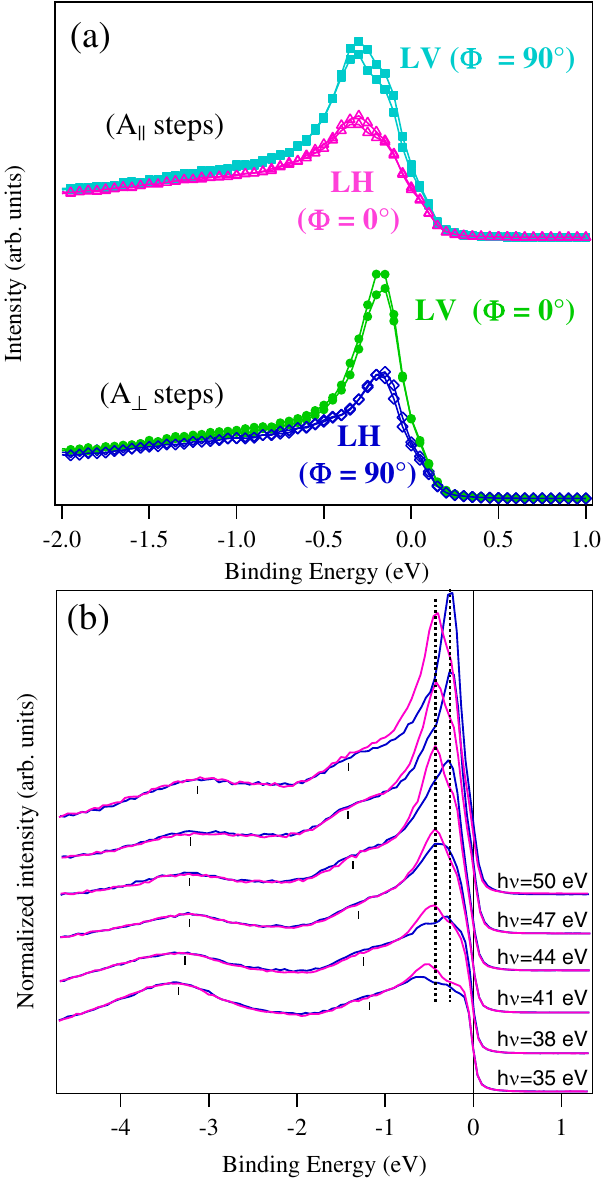
Figure 4. ( a ) EDCs measured in normal emission for LH and LV polarizations. The measurements show the presence of two states when A is parallel to the steps and one when it is perpendicular (see text for details). ( b ) Photon energy dependence of the EDCs measure with LH polarization along the [1 0 0] ( Φ = (0°)) and [0 − 1 0] ( Φ = (90°)) directions in the range from 50 eV to 35 eV for LH. The steeply increasing intensity in this photon energy range uniquely identifies the d origin of the states 35 . The constant kinetic energy as a function of the photon energy confirms its surface state character. Below 40 eV they decay into surface